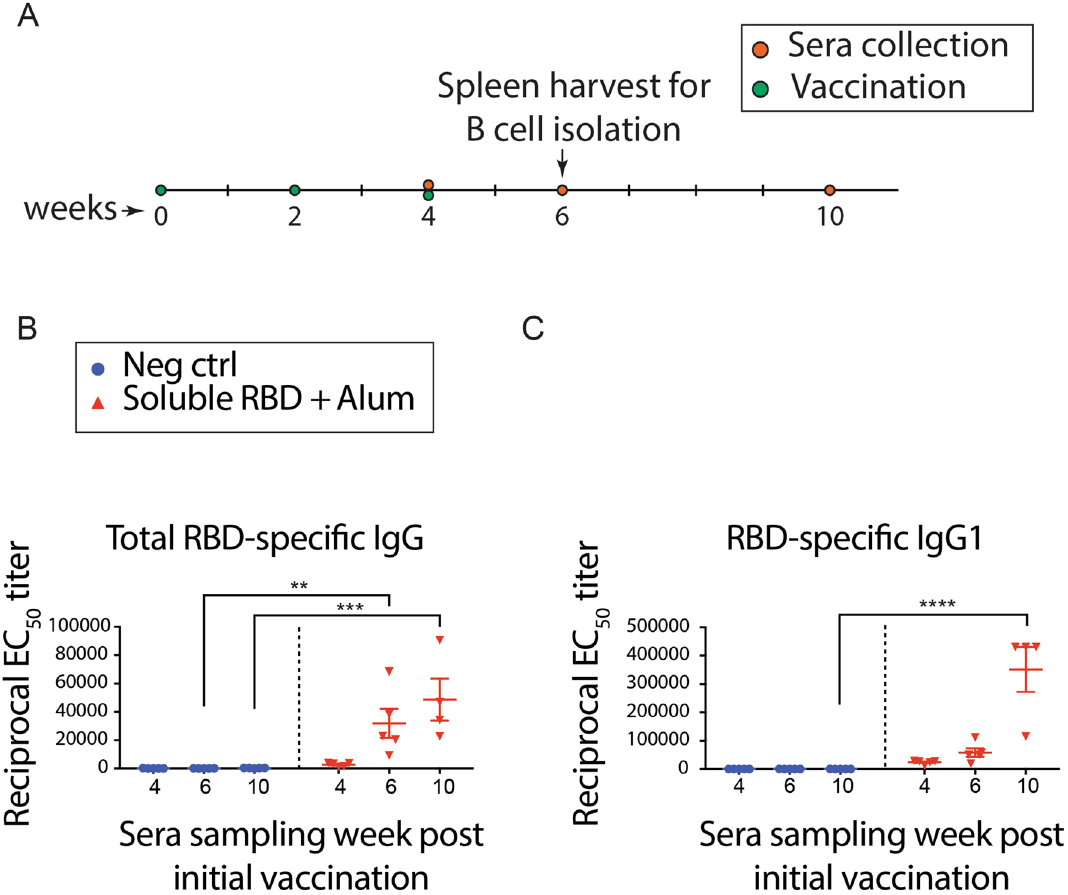
**p < 0.01, ***p < 0.001, and ****p < 0.0001 by two-way ANOVA followed by row